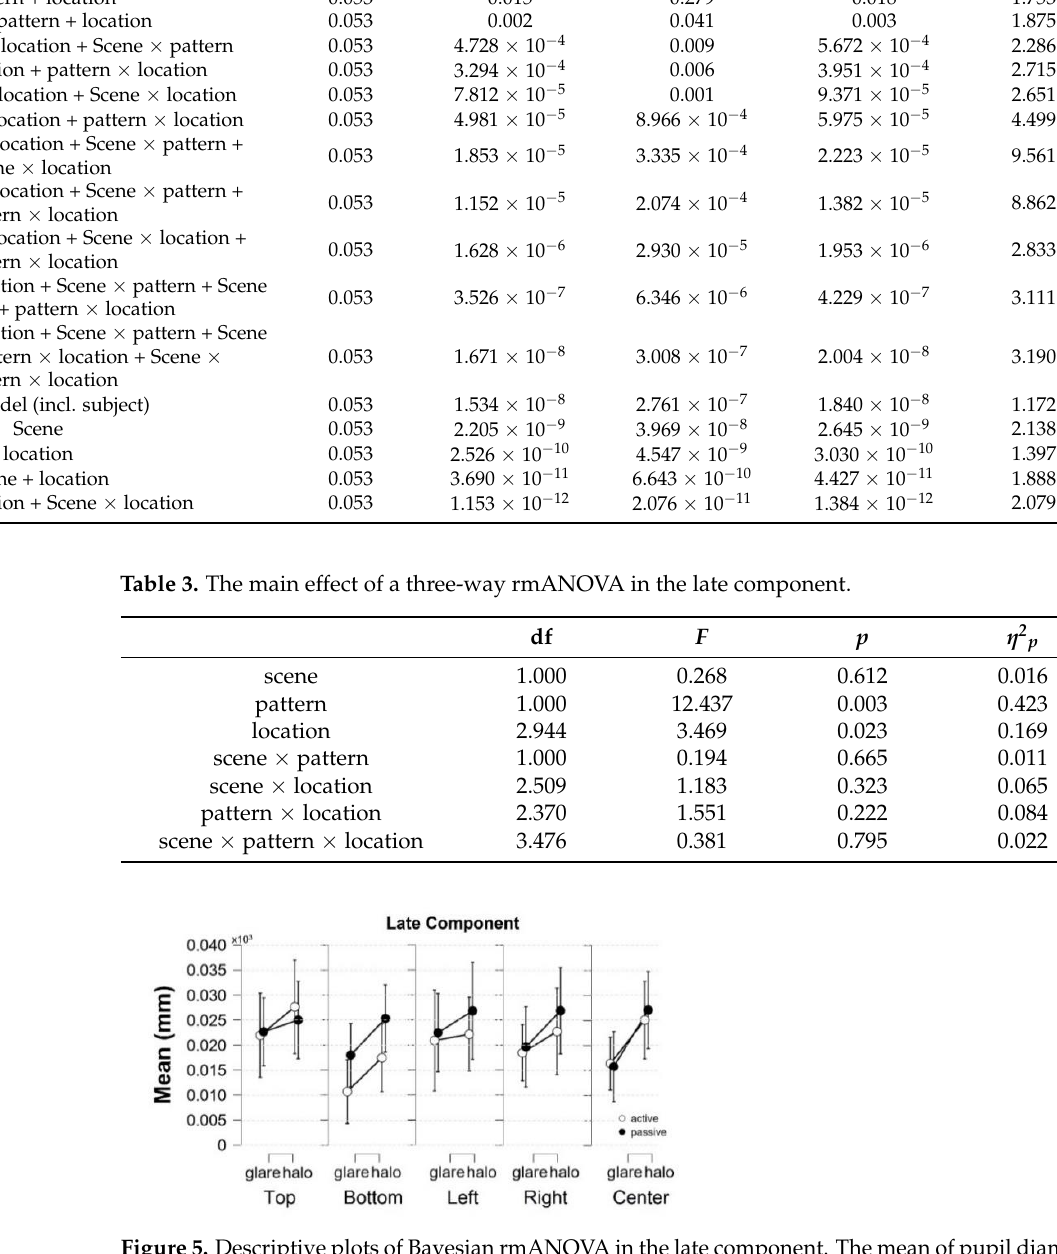
Table 4. Model comparison using Bayesian rmANOVA in the late component.